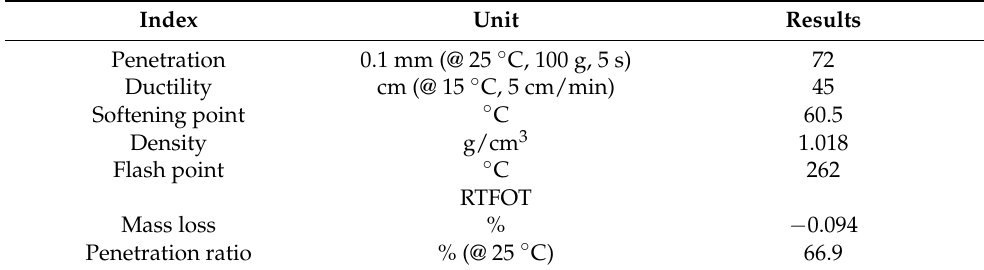
Table 1. Technical properties of SBS-modified asphalt.